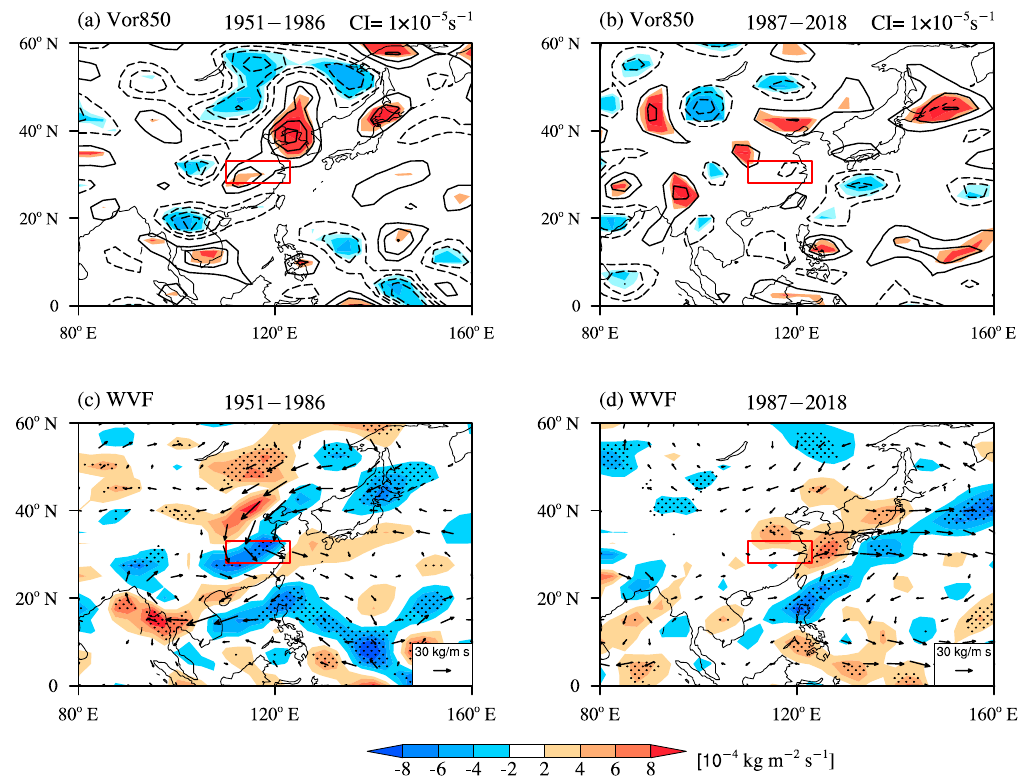
Figure 5. Regression maps of ( a , b ) relative vorticity (contour; unit: s − 1 ) at 850 hPa with respect to the normalized IPWP index for 1951–1986 and 1987–2018, respectively. ( c , d ) Same as for ( a , b ) but for the water vapor flux integration of 1000– 300 hPa (vector; unit: kg m − 1 s − 1 ) and its divergence (shading; unit: 10 − 4 kg m − 2 s − 1 ). In (a–d), positive (negative) values are indicated by solid (dashed) contours with the zero contour omitted. The three orange (blue) shadings from shallow to deep in ( a , b ) indicate that positive (negative) anomalies are significant at the 90%, 95%, and 99% confidence levels based on a two-tailed Student’s t test, respectively. The dotted regions in ( c , d ) indicate the 90% confidence level based on Student’s t test. The red boxes indicate the YH-R basin.